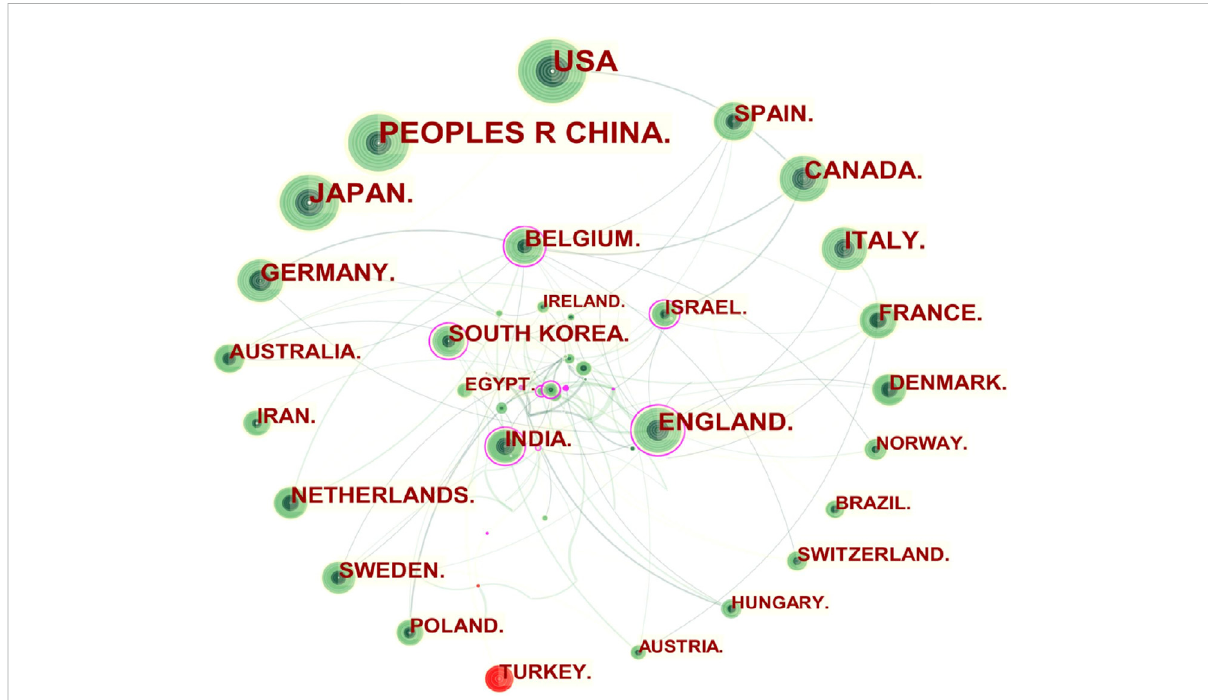
FIGURE 2 Network of countries and regions engaged in UC research. Note: An individual node represents a country or region on the network map. The greatertheareaofthenode,themorepublicationsthereare.Thethickerthecurved lineconnecting nodes,themorefrequenttheirco-occurrence, as this indicates a collaborative relationship. An isolated node with no link lacks all collaboration. When a node has a high betweenness centrality ( > 0.1) (i.e., when it is connected to more than 10% of the other nodes), it exerts signi fi cant in fl uence over others as it controls most resources within their collaborative networks (Cobo et al., 2011). The presence of a purple rim also indicates a high degree of betweenness centrality. Red tree rings indicate bursts of citation, indicating high scholarly activity. Red tree rings with a greater thickness show a greater burst for a corresponding